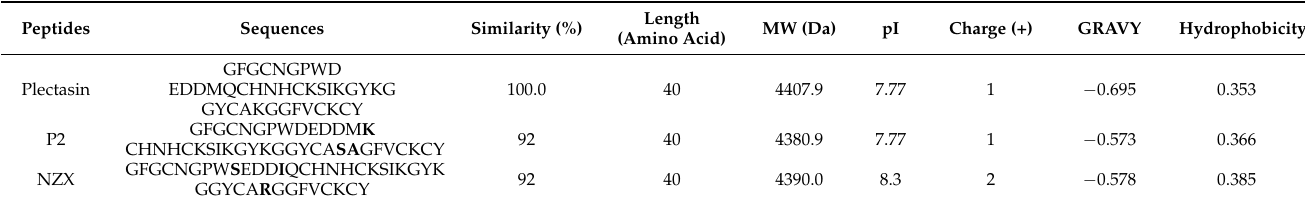
Table 5. Amino acid sequences and physicochemical properties of peptides